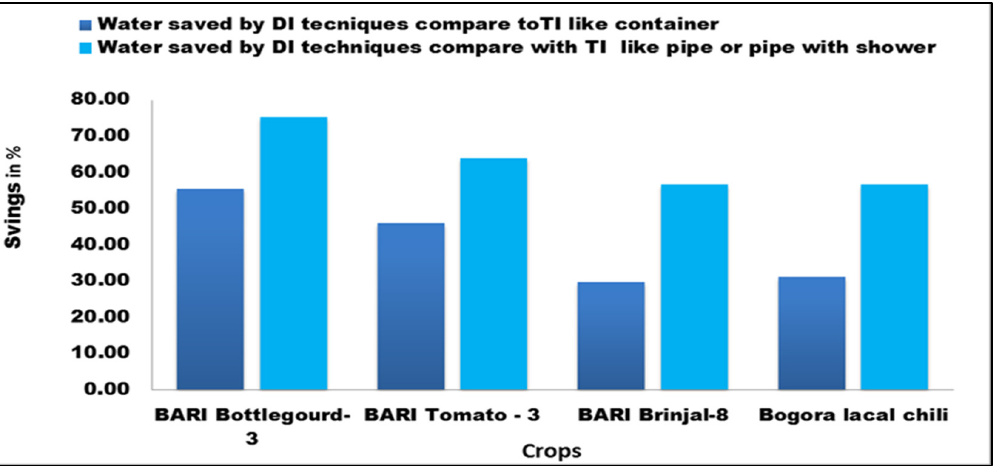
Figure 6. Percentage of water-saving compared to traditional irrigation approaches.